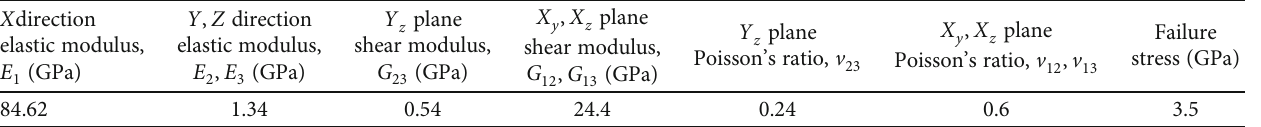
Figure 21: Strain cloud map corresponding to the change of diameter of the riveting joint in nylon ribbon. Table 7: Kevlar ribbon parameters.